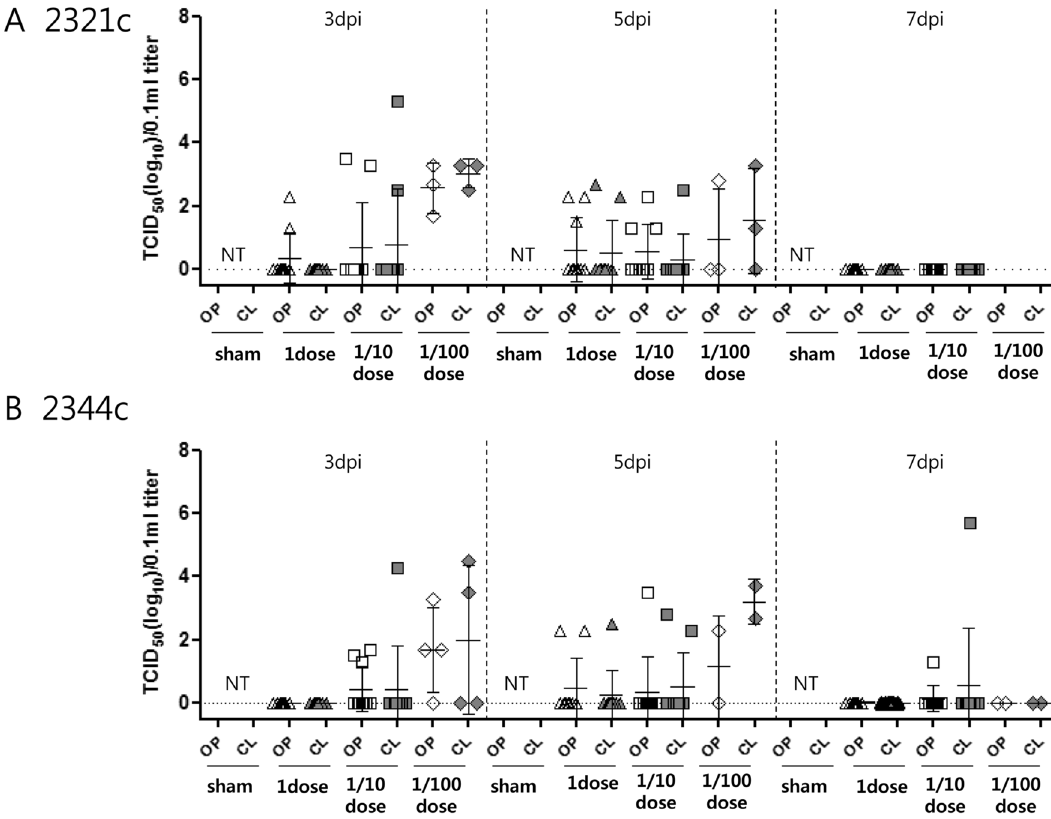
Figure 4. Virus shedding in oropharyngeal (OP) and cloacal (CL) swab samples after inoculation with homologous HPAIV. Titers of virus shed in OP and CL samples from chicken sham-vaccinated or inoculated with vaccines at one (1) dose, one-tenth (1/10) dose, or one-hundredth (1/100) dose; titers were measured at 3, 5, and 7 days post-infection (dpi) with each homologous H5 HPAIV. Viral titers are expressed as log 10 TCID 50